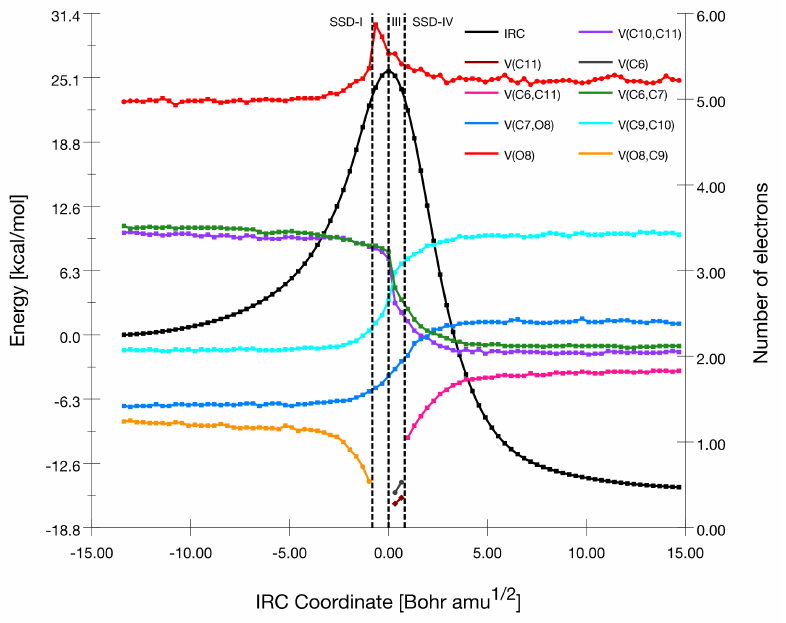
Figure 1. Population evolution (in e) of selected basins along the IRC associated with TS1 .